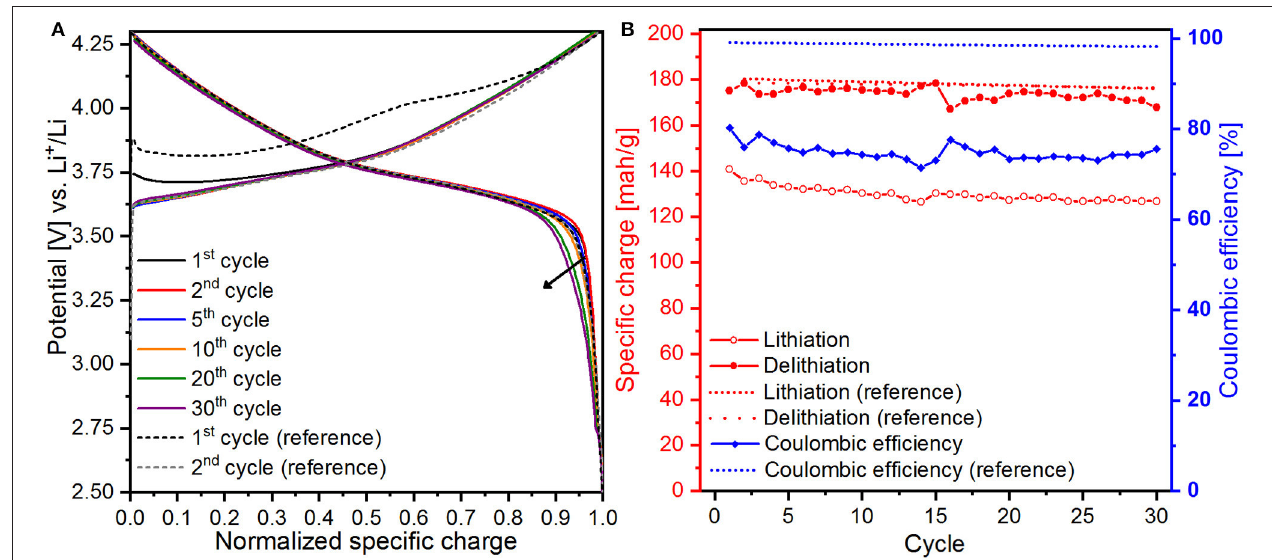
FIGURE 9 | (A) Normalized galvanostatic curves and (B) evolution of the specific charge and coulombic efficiency from the cycling of NCM622 in the cylindrical cell and in standard-type coin cell (reference) for 65 cycles. For clarity, only the linear fit of the reference set of data is represented.